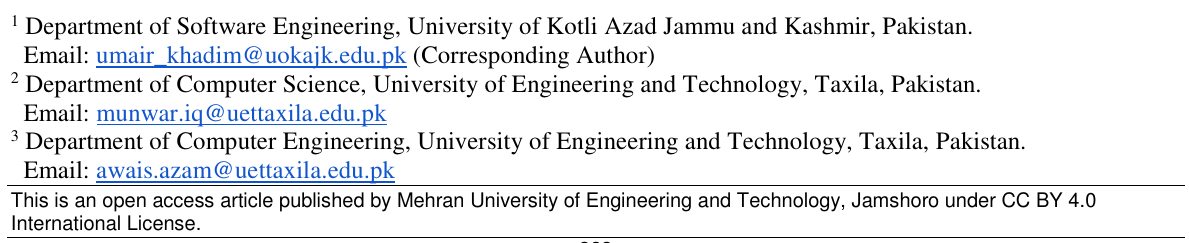
Fig. 1: Information Security